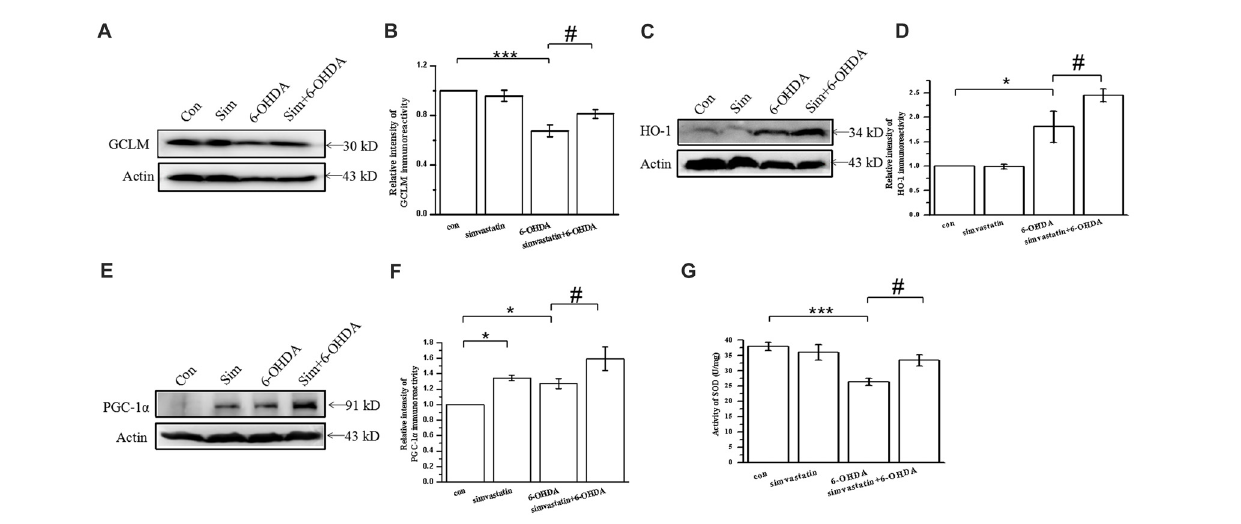
FIGURE 5 | Simvastatin exerted an antioxidant protective effect by enhancing expression of antioxidative proteins in 6-OHDA-treated SH-SY5Y cells. SH-SY5Y cells exposed to 1 µ mol/L simvastatin and 100 µ mol/L 6-OHDA. (A) Expression of glutamate-cysteine ligase modifier subunit (GCLM) detected by western blot after 24 h. (B) Relative quantitative analysis of GCLM expression. (C) Expression of heme oxygenase-1 (HO-1) detected by western blot after 12 h. (D) Relative quantitative analysis of HO-1 expression. (E) Expression of peroxisome proliferator-activated receptor- γ coactivator-1 α (PGC-1 α ) detected by western blot after 12 h. (F) Relative quantitative analysis of PGC-1 α expression. (G) Total superoxide dismutase (SOD) activity of SH-SY5Y cells determined using a Beyotime Total SOD Assay Kit. Data were obtained from three independent experiments. Statistical analysis by Dunnett’s T3 or LSD post hoc test based on ANOVA; data expressed as mean ± SEM. ∗ P < 0.05, ∗∗∗ P < 0.001, # P <